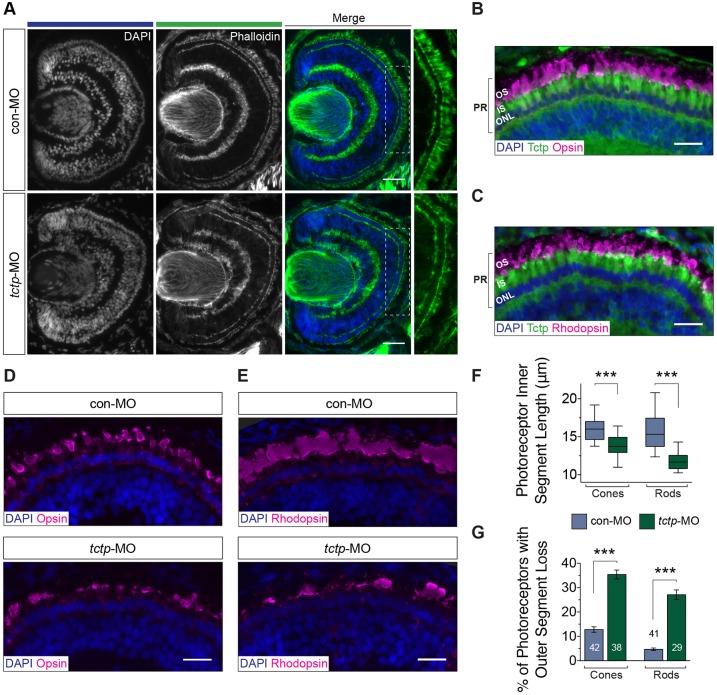
Tctp is not necessary for the timely development of the eye. (A) Representative stage 43 control and Tctp-depleted retinas stained with phalloidin and DAPI. The boxed areas are shown at a higher magnification to the right. (B,C) Immunohistochemistry analysis of the photoreceptor layer in stage 43 wild-type retinas probed with anti-Tctp and anti-opsin or anti-rhodopsin antibodies, and counterstained with DAPI. IS, photoreceptor inner segment; ONL, outer nuclear layer; OS, photoreceptor outer segment; PR, photoreceptor. (D,E) Representative micrographs of the photoreceptor layer in stage 43 control or Tctp morphant retinas probed with anti-opsin or anti-rhodopsin antibodies, and counterstained with DAPI. (F) Average inner segment lengths in control and Tctp morphant retinas. ***P<0.0001, unpaired t-test; box plot whiskers denote 5th-95th percentile. (G) Proportion of photoreceptors showing a complete loss of the outer segment in control and Tctp morphant retinas. n, number of photoreceptor layers analysed; ***P<0.0001, unpaired t-test. Scale bars: 50 μm in A; 25 μm in B-E.